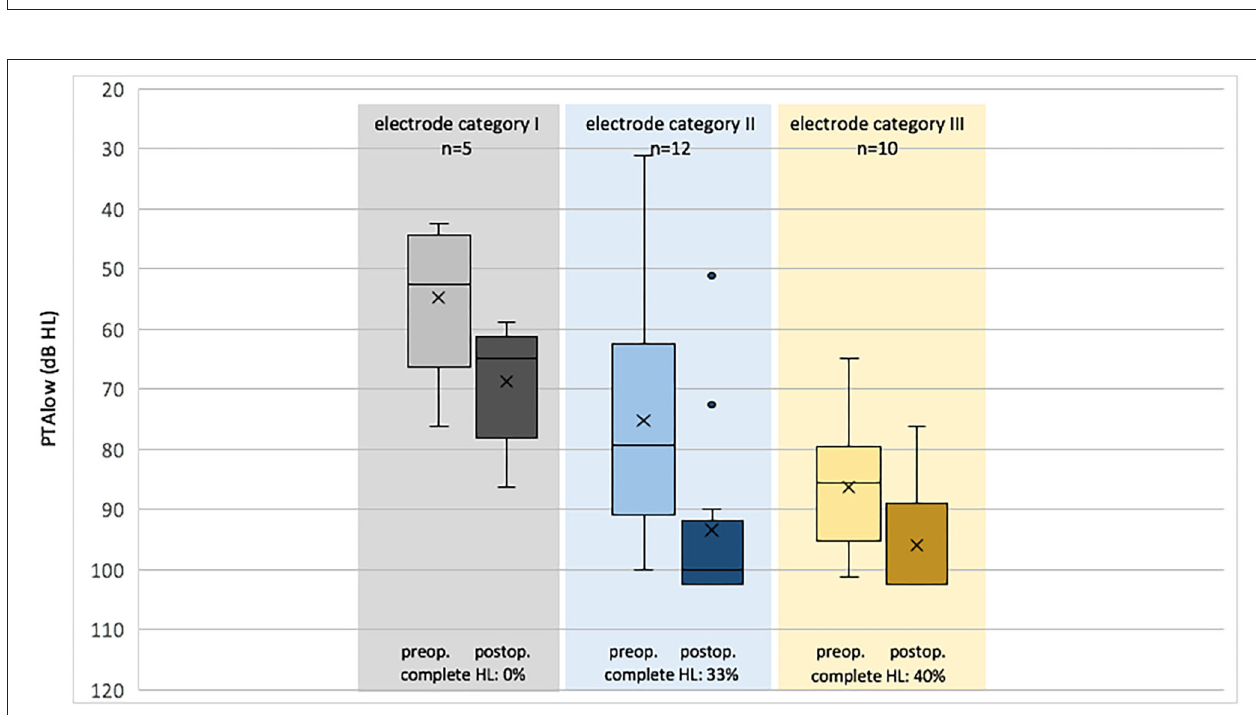
FIGURE 5 | Pre- and post-operative PTAlow (averaged unaided air conduction threshold, 125, 250, 500, and 1,000Hz, boxplots) grouped by electrode category (I, structure-preserving; II, potentially structure-preserving; III, not structure-preserving).